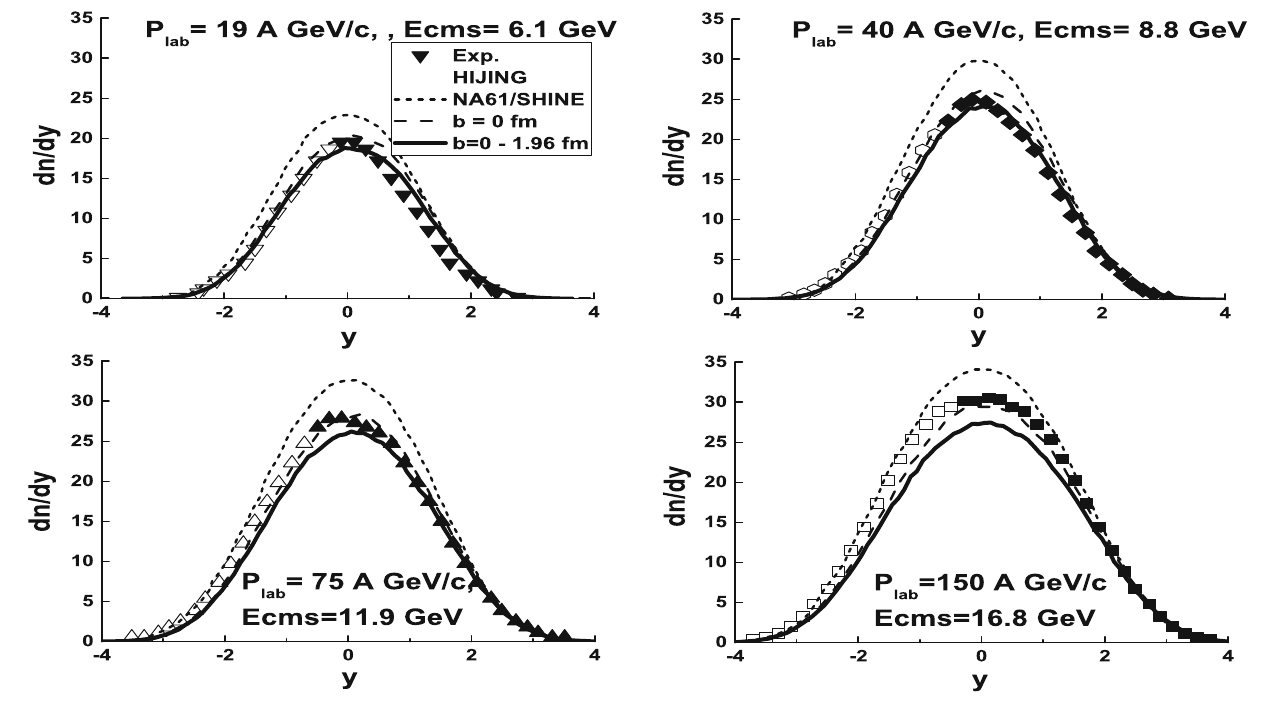
The HIJING model calculations presented by the collaboration [1] are shown by short dashed lines. The dashed lines are our results for b = 0. The solid lines were obtained for b = 0–1.96